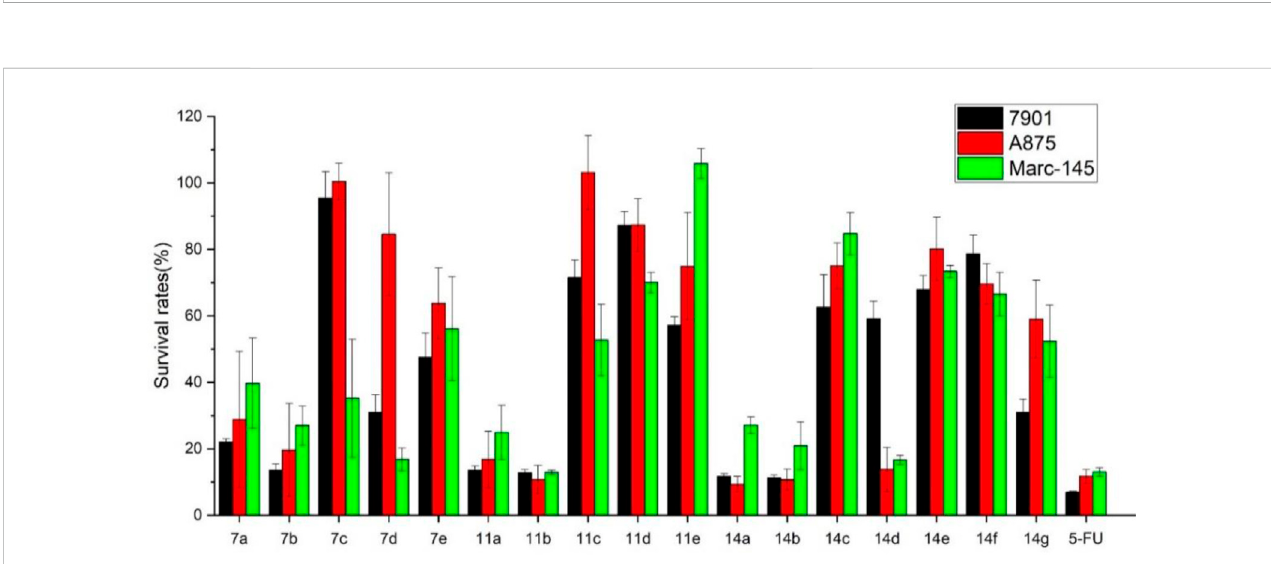
FIGURE 3 Cytotoxic activities of synthesized compounds at the concentration of 40 μ g/mL. Abbreviations: 7901 — Human gastric cancer cell line; A875 — Human melanoma cell line; MARC145 — A subclone of African green monkey kidney cell line MA-104; 5-FU — 5-Fluorouracil, used as a positive control.